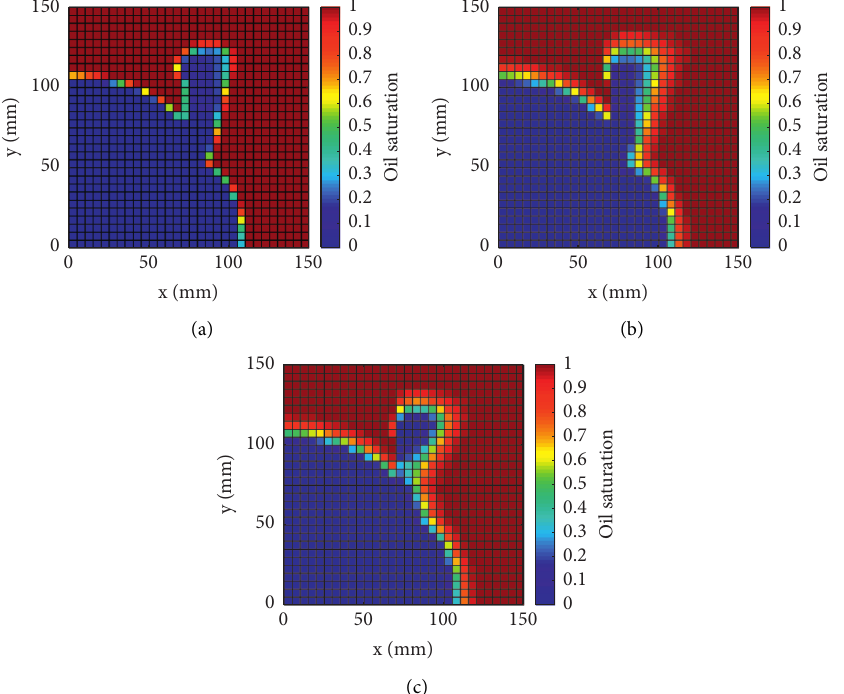
Figure 11: Oil saturation profiles for (a) upscaled fine grid simulation, (b) pIEDFM, and (c) EDFM after 1800seconds of